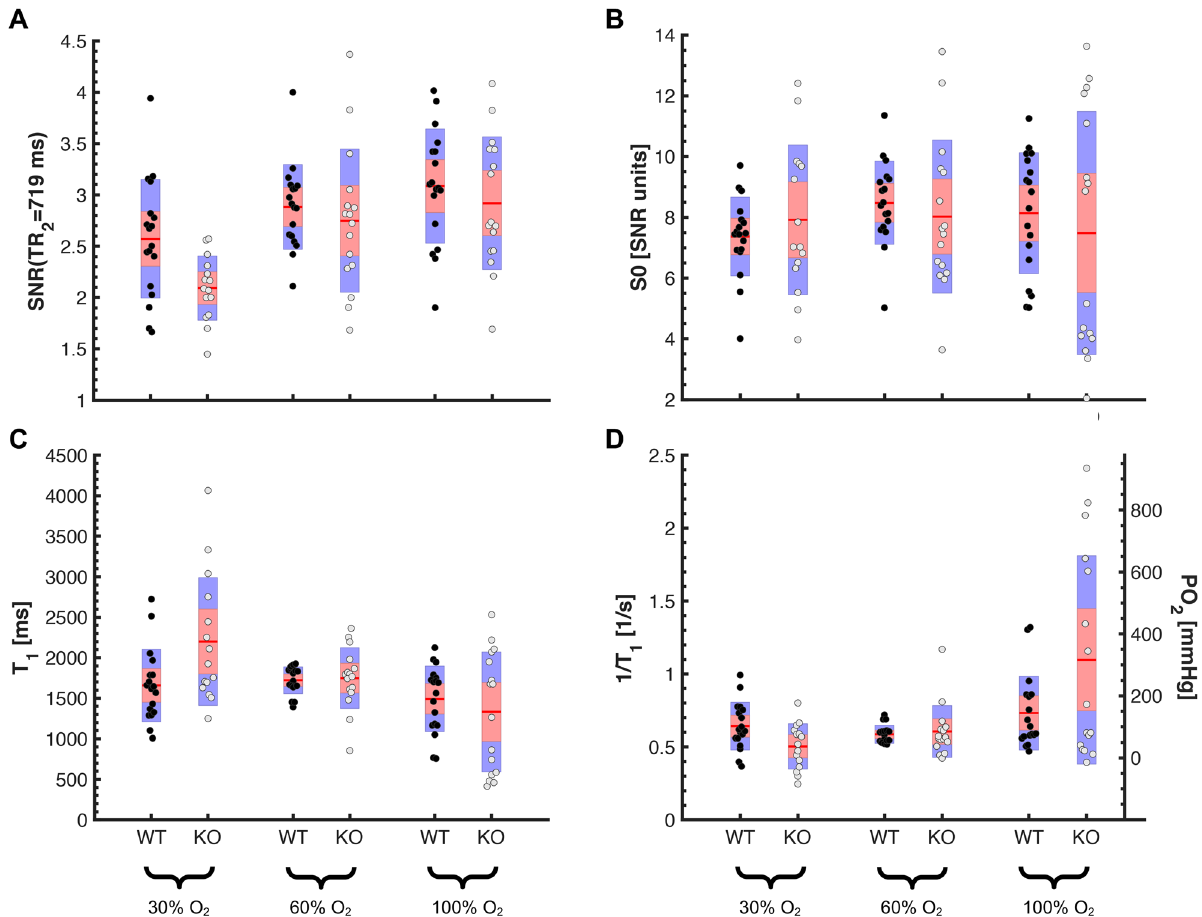
Figure 3. Descriptive statistics of 19 F MRI parameters in Lgals1 wildtype (WT, black circles) and knockout (KO, gray circles) placentas at 30%, 60% and 100% oxygen in breathing air. Shown are ( A ) signal to noise ratio on one of the T 1 -weighted images, ( B ) fitted relative 19 F concentration S 0 , ( C ) fitted T 1 relaxation time and ( D ) calculated PO 2 ~ 1/T 1 . Increasing the amount of oxygen in breathing air led to an apparent increase in SNR, decrease in T 1 and increase in PO 2 but also an increase in variance. Parameters indicative of decreased oxygenation in knockout animals were only obvious at 30% oxygen. Red lines show mean, red and blue areas correspond to 95% confidence intervals and standard deviation,